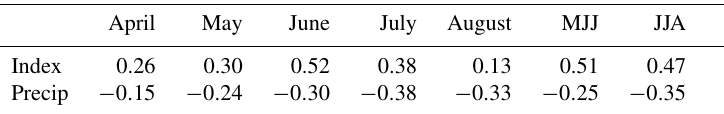
Figure 1. Drought and precipitation index for Sweden 1500–1816CE. Note that we wish to thank Fredrik Charpentier Ljungqvist of Stock- holm University for his help with the graphs. Table 1. Correlation between average monthly and seasonal temperatures in Stockholm and with the drought index of 1756–1816CE (first row) and with the corresponding monthly and seasonal precipitation data from Stockholm for the period 1859–2011CE (second row; daily observations are summed to monthly or seasonal values).